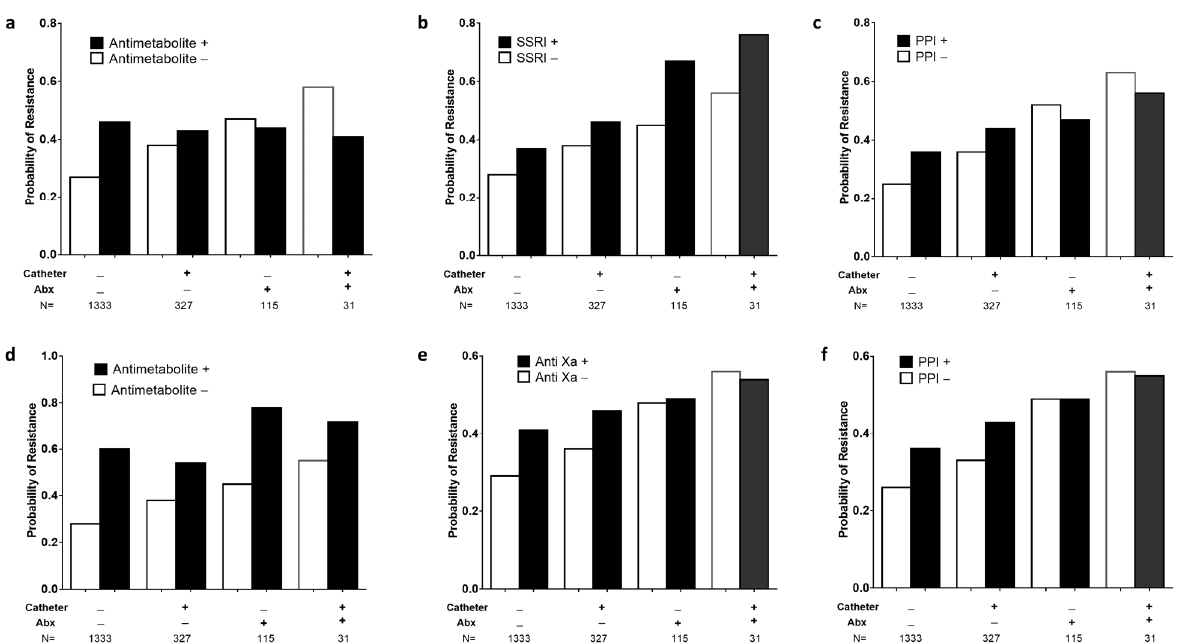
Figure 3. Effect of patient covariates and non-antimicrobial treatment on probability of antibiotic resistance. Bars show the treatment effects model derived probability of antibiotic resistance phenotype, as a function of exposure to non-antimicrobial drugs and 2 patient covariates, indwelling urinary catheter (Catheter) and exposure to antibacterial agents (Abx). Panels ( a – c ) show probability of resistance to ceftriaxone, and panels ( d – f ) show resistance to trimethoprim-sulfamethoxazole. SSRI: selective serotonin reuptake inhibitor; PPI: proton pump inhibitor .